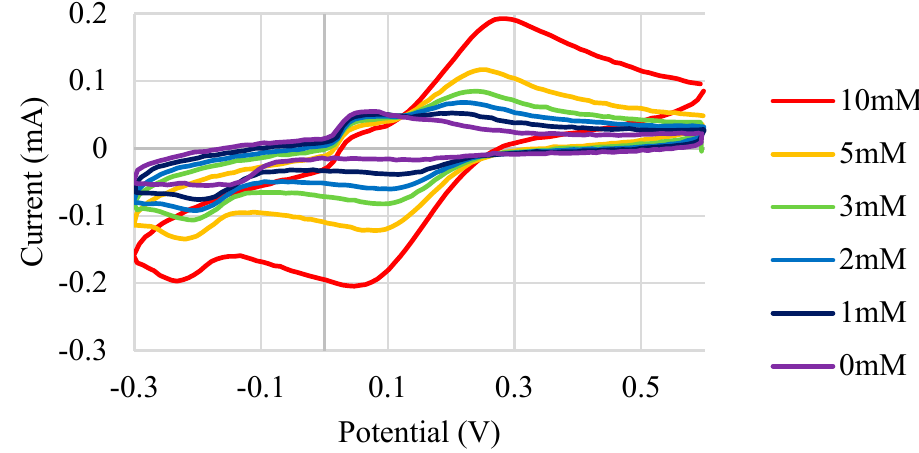
Figure 8. CV curves with K 3 Fe(CN) 6 as a redox mediator for Design 2.